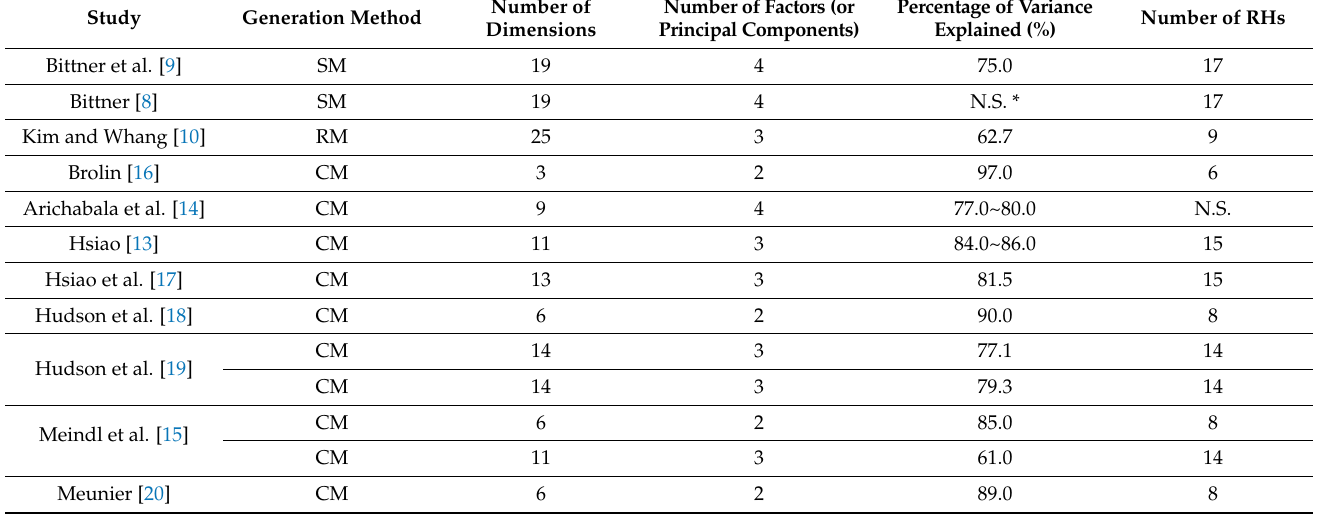
Figure 2. Limitations of multivariate generation methods of representative humanoids (RHs). AD, anthropometric dimensions; F, factor. Small dots: Anthropometric cases of the target population; large dots: RHs; dashed lines: Accommodation boundaries. Table 1. Summary of the existing studies using multivariate representative humanoid generation methods (SM, square method; RM, rectangular method; CM, circular method).